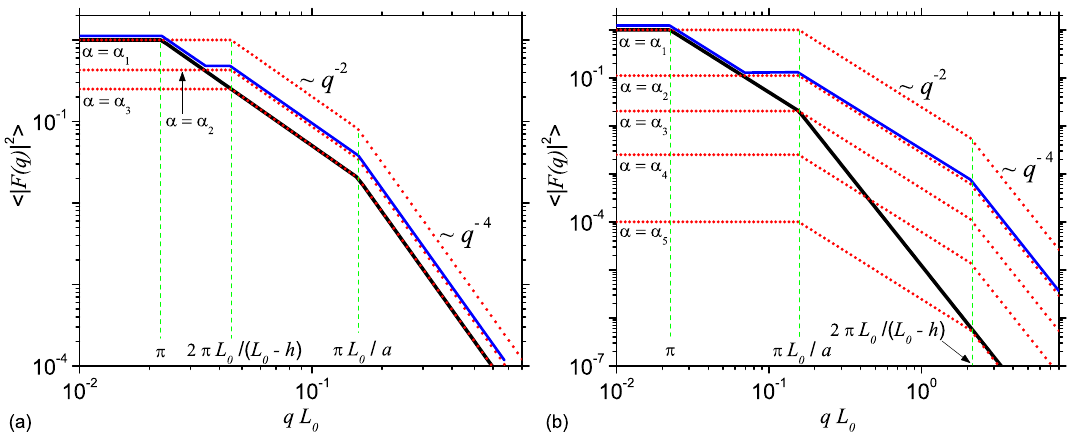
Figure 5. (Color online) Generic normalized SAS intensity from a cylinder, as a function of momentum transfer: ( a ) L 0 − h ≥ 2 a . ( b ) L 0 − h < 2 a . Black curve (continuous): SAS intensity < | F 1 ( q ) | 2 > (Equation (14)) from a cylinder of length 2 L 0 and radius 2 a . Red curves (discrete): SAS intensity ( 1 − α ) α − 1 < | F ( q ) | 2 > , at fixed values of contrast parameter α . The blue curves (slightly shifted 2 vertically, for clarity) show the envelope of black and red curves corresponding to F 1 ( · ) and F 2 ( · ) at α = α 2